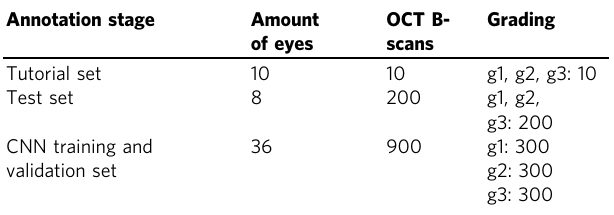
Table 1 Overview of data sets acquired for this